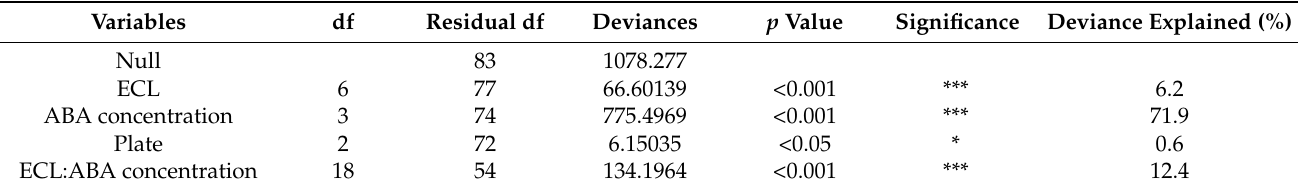
Table 6. Summary of deviances of the generalized linear model (GLM) of data from Table 5 (Effect of abscisic acid (ABA) concentration on somatic embryo maturation efficiency of sugi embryogenic cell lines (ECLs)). Deviance of the variable “null” indicates the null deviance (deviance of the null model), and other deviances indicate the residual deviance (deviance of the